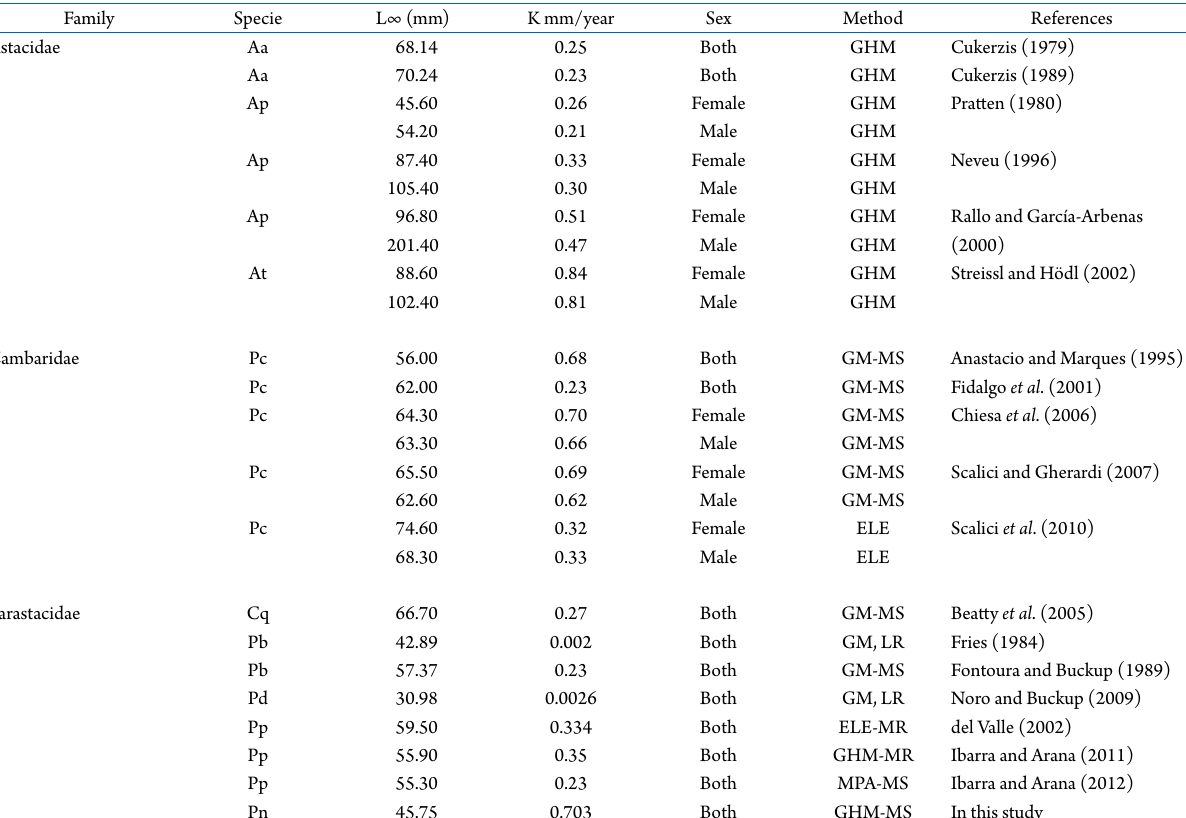
Figure 1. Size-weight relationship of the burrowing crayfish Parastacus nicoleti . Table 3. Individual growth parameters of some crayfish